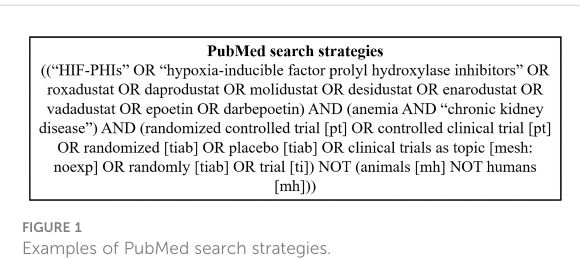
FIGURE 1 Examples of PubMed search